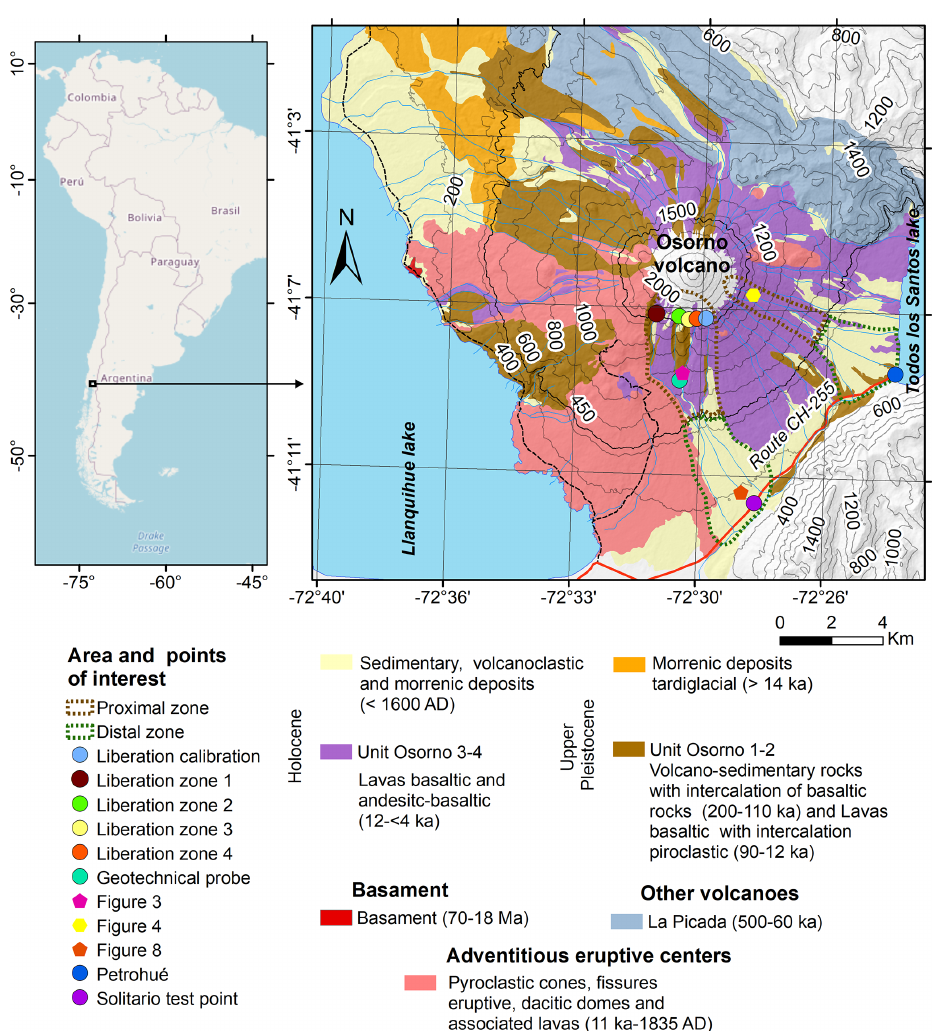
Figure 1. Geological map of Osorno volcano based on Moreno et al. (2010).